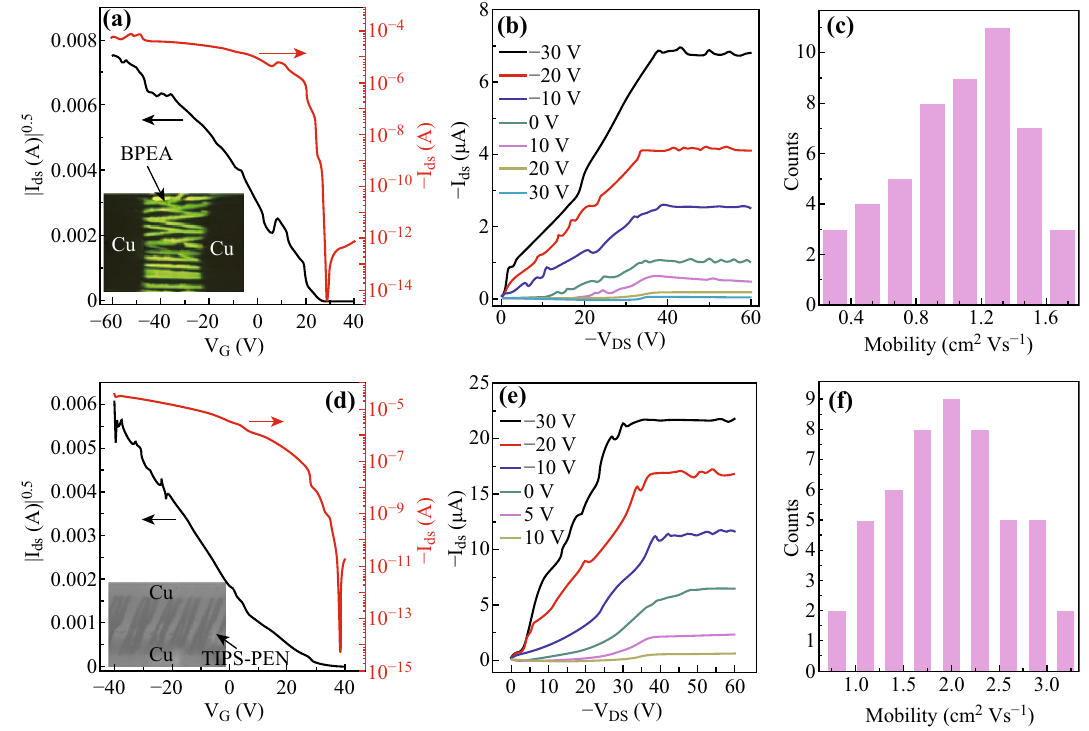
Fig. 6 Typical transfer ( V DS = - 50 V) and output characteristics of BPEA ( a , b ) and TIPS-PEN ( d , e ) nanoribbon array-based OFETs with optimized device configurations on SiO 2 /Si substrates. Insets in a and d show the typical optical images of the BPEA and TIPS-PEN-based OFETs, respectively. Corresponding statistical diagrams of mobilities are shown in c and f for BPEA and TIPS-PEN nanoribbon array-based OFETs,